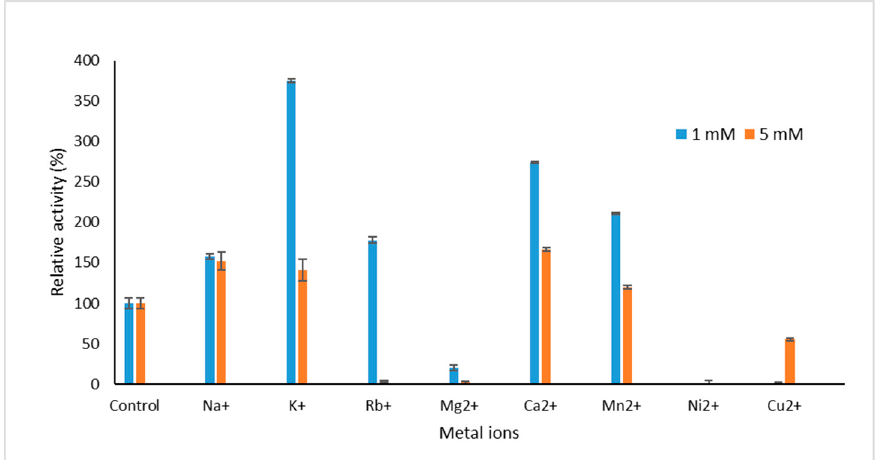
Figure 7. Effect of metal ions on the activity of purified GlaEst12-like esterase. The relative activity of the unincubated enzyme without metal ions (control) was taken 100%. Error bar represents standard deviation ( n = 3).